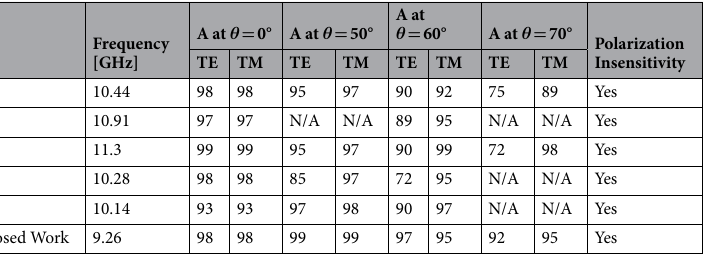
Table 2. Compared performance at the specular angle of the proposed metamaterial absorber with other angle- insensitive metamaterial